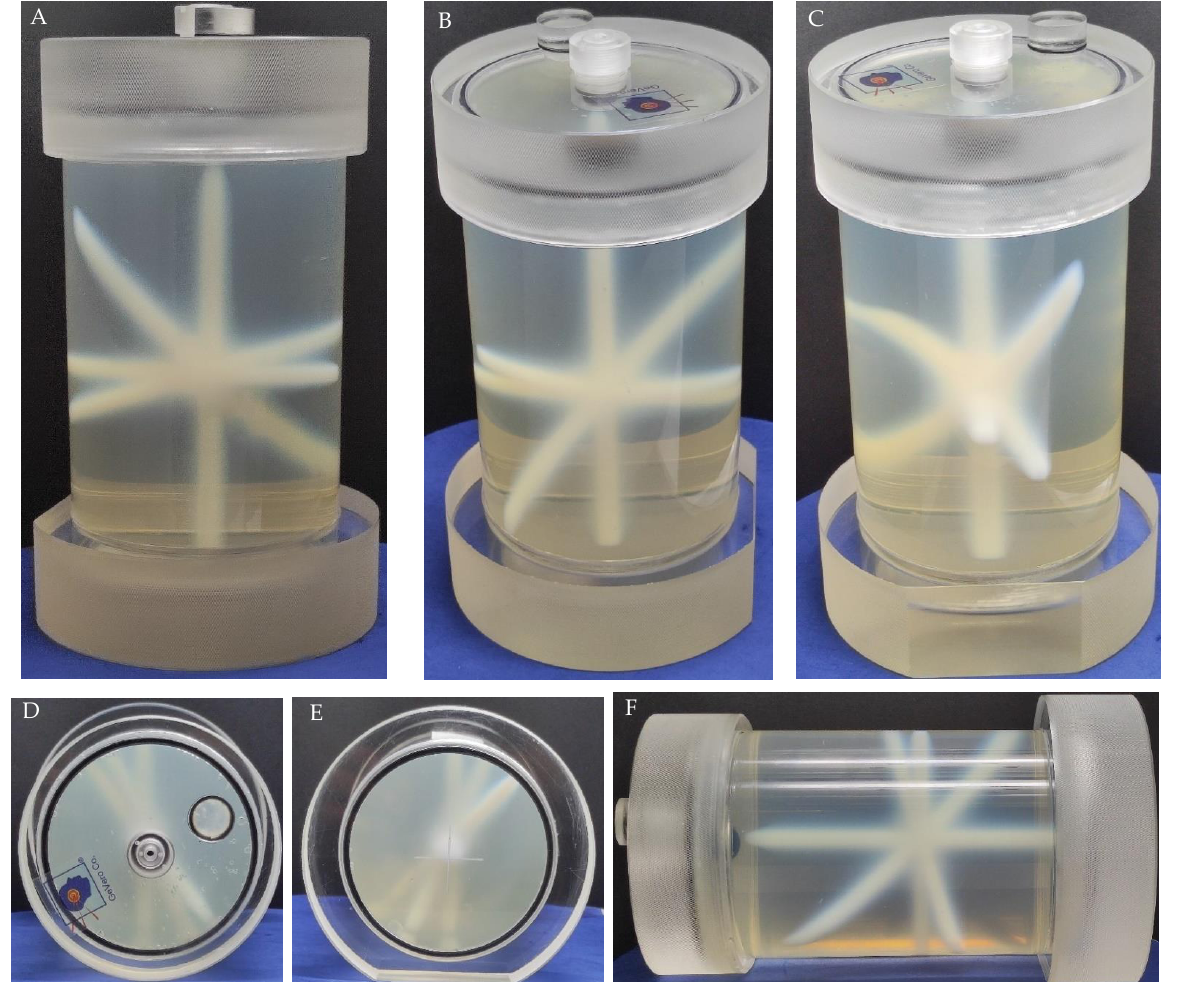
Figure 9. Isocenter determination: 3D option. PABIG nx in PH-5-DD1 GeVero Co. container was irradiated ( A – F ) and scanned with a TrueBeam accelerator (iCBCT, mode: Pelvis, mean over 3 series). The photographs in ( A – C ) are for the rotated sample (( A ): 0°, ( B ): 180° and ( C ): 270°) to better inspect of the irradiation pattern; ( D , E ) are the top and bottom views, respectively, and ( F ) is the side view.